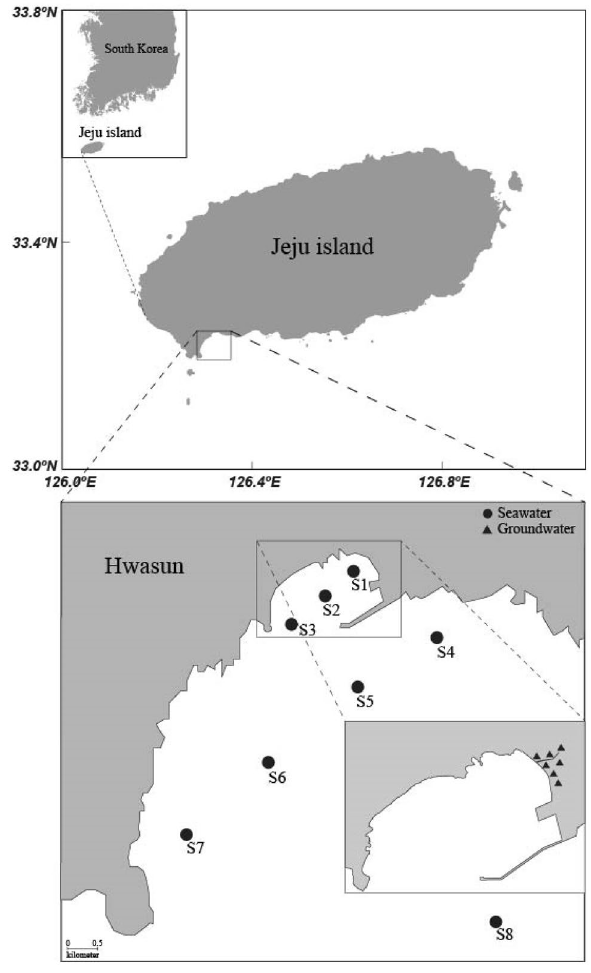
Figure 4. A map showing the study site, Hwasun Bay of Jeju Island, and sampling locations of seawater (circle) and groundwater (triangle) in October 2018. This figure was drawn using Adobe Illustrator Version